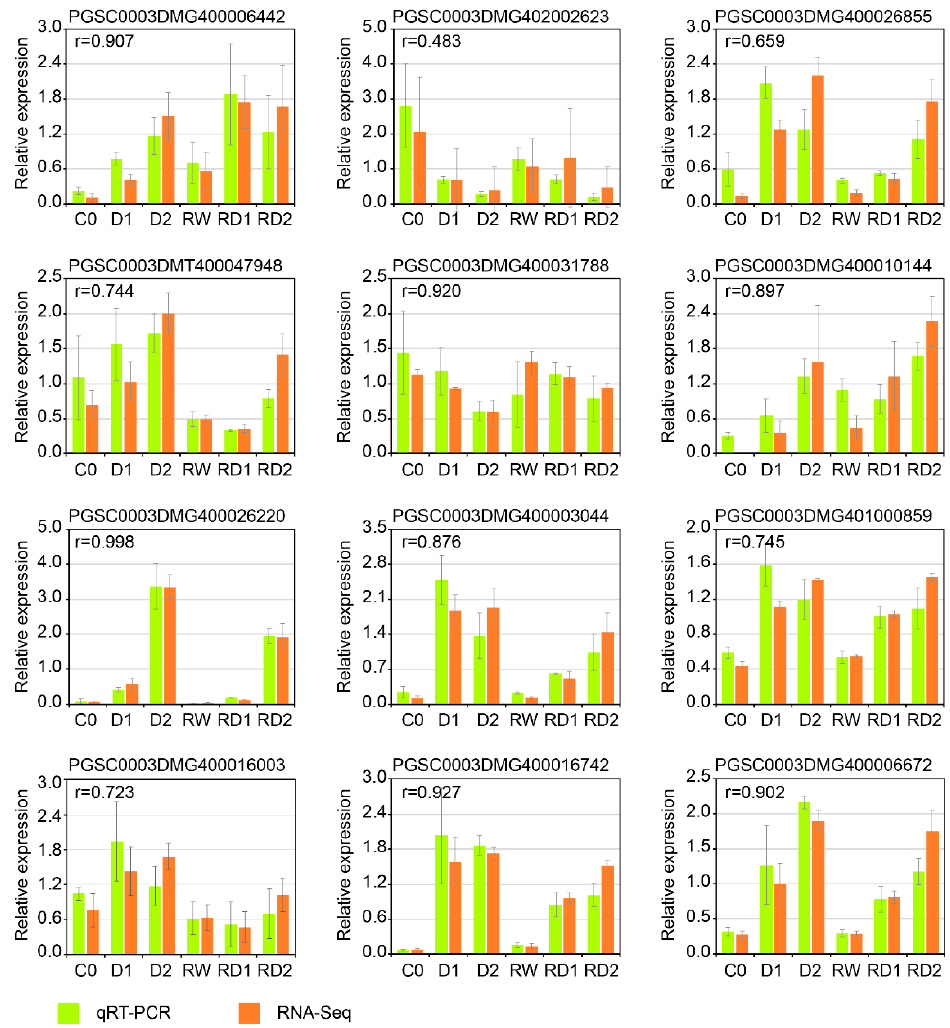
Figure 7. The expression analysis of 12 DEGs by qRT-PCR (yellow green) and RNA-seq (dark orange). The Pearson’s correlation coefficients (r) are labeled at the upper left corner. All the expression values of each gene were normalized by dividing the expression means of six treatments.